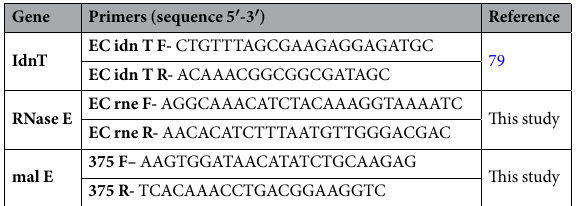
Table 3. List of primers used for qRT-PCR. For quantification of transcripts of ACLSV MP , primers were designed from the nucleotide sequence of maltose binding protein present in pMAL vectors. The RNase E primers were designed from RNase E sequence derived from the genome of an E. coli K-12 strain MG1655